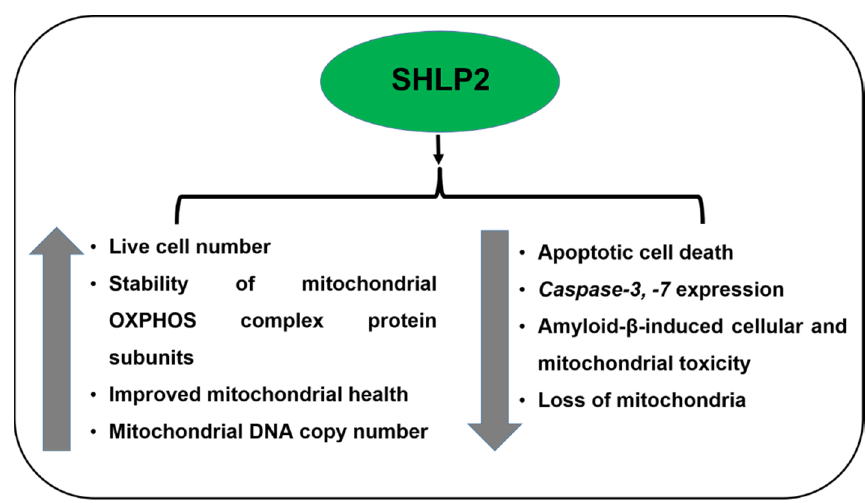
Figure 3. Effects of SHLP2 in AMD. Figure 3. E ff ects of SHLP2 in